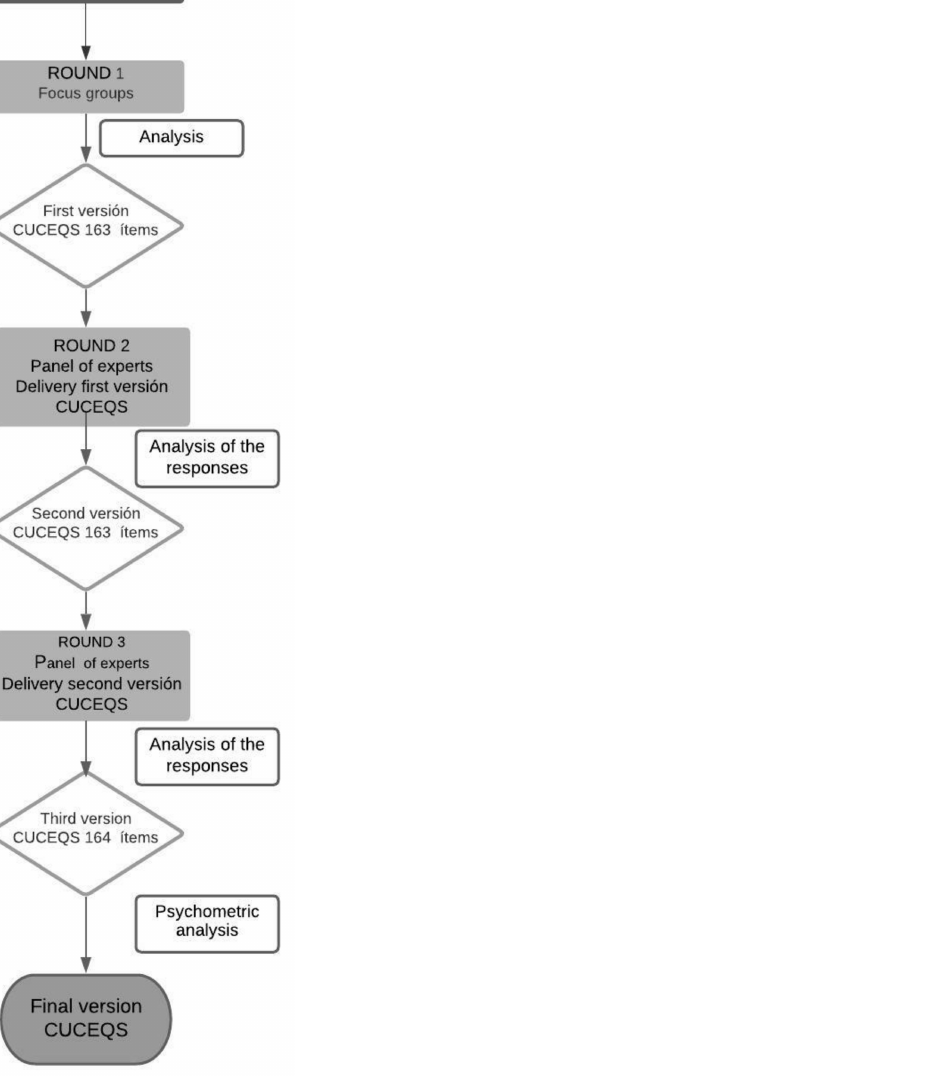
Figure 1. This is a figure of the procedure for the design of the CUCEQS©